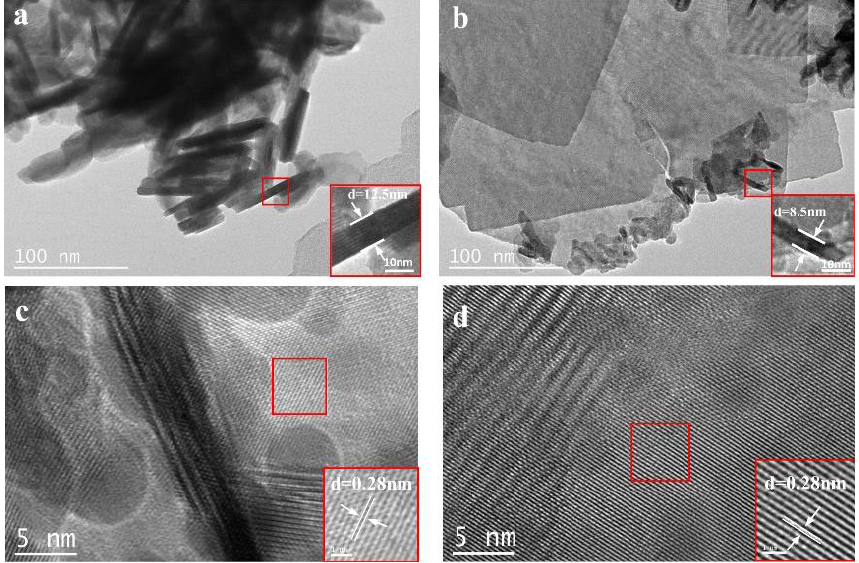
Figure 3. TEM ( a , b ) and HRTEM ( c , d ) of Bi 4 O 5 Br 2 and 5%Fe-Bi 4 O 5 Br 2